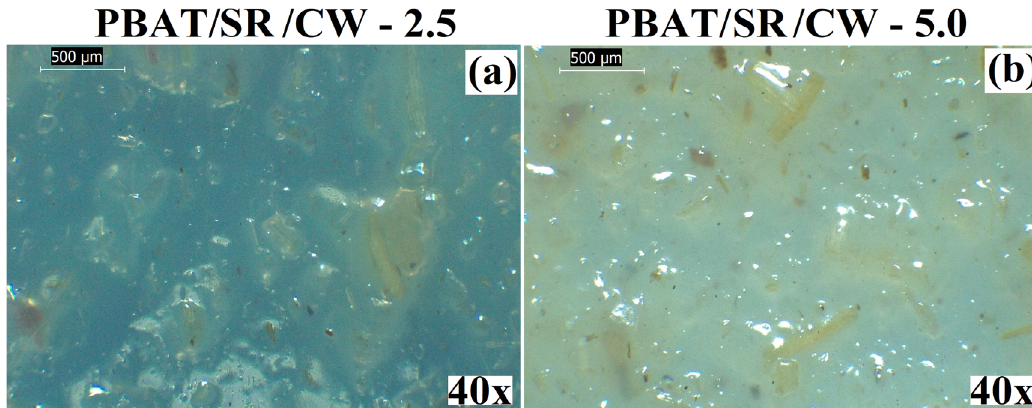
Figure 6. Optical microscopy of the surface: a) PBAT/SR/CW - 2.5 mulch films and b) PBAT/SR/CW - 5.0. (colored in the online